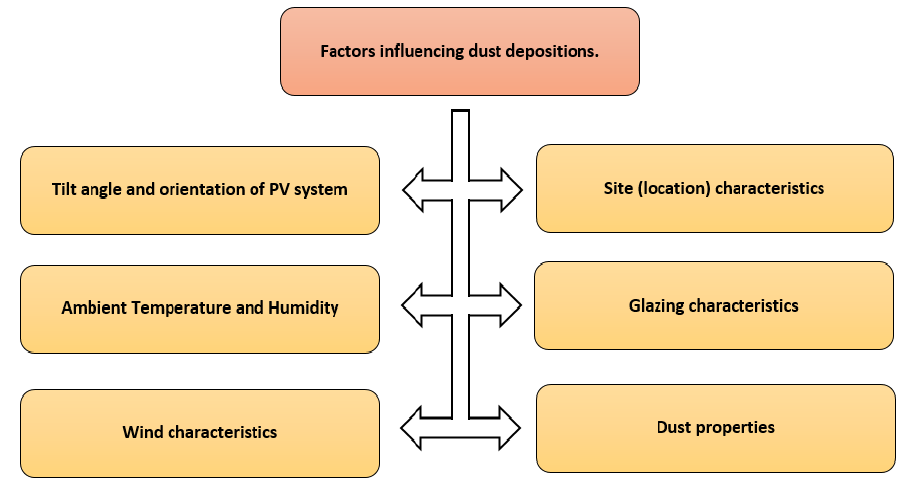
Figure 1. Factors influencing dust depositions on the surface of PV panels.